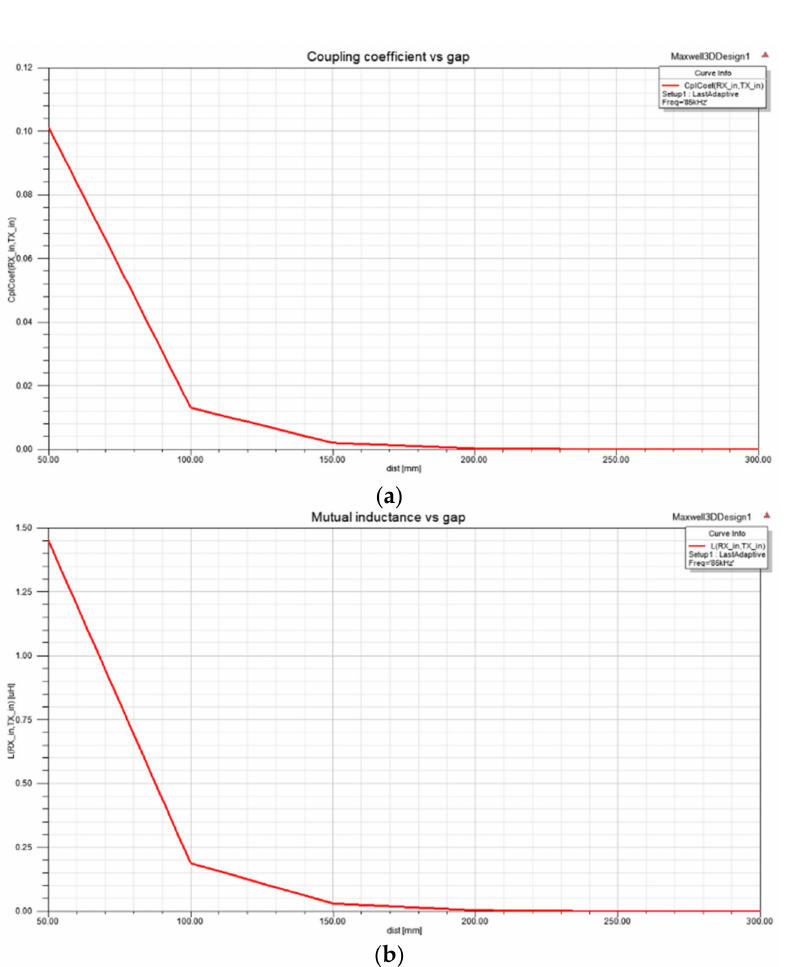
Figure 8. Rectangular coil model with ferrite: ( a ) coupling coefficient versus the gap variation, ( b ) mutual inductance versus the gap